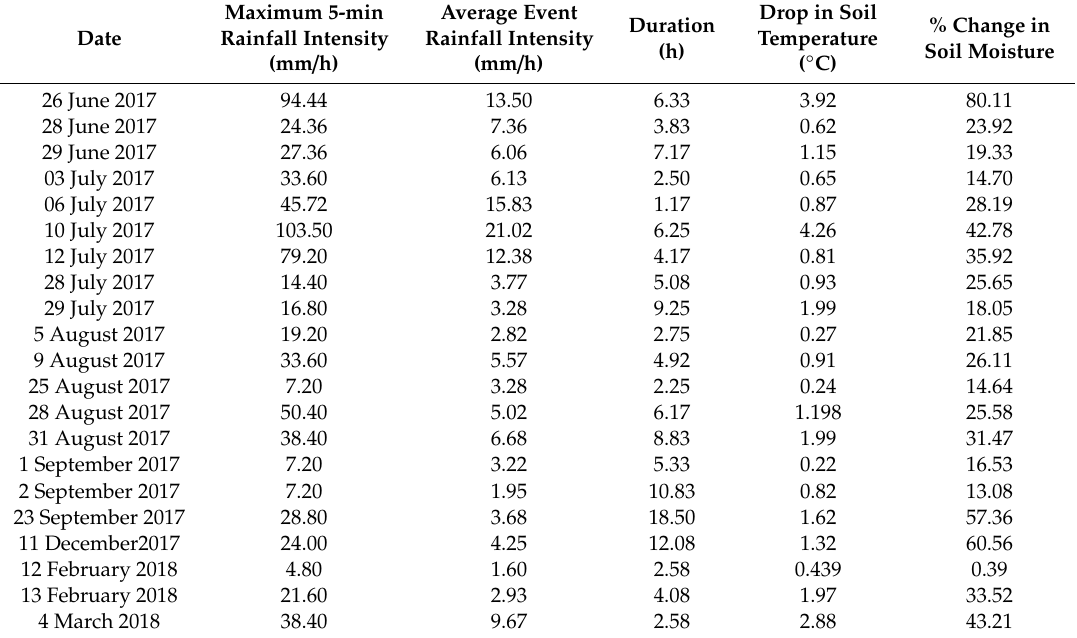
Table 2. Characteristics of selected rainfall events with corresponding changes in soil temperature and moisture in AgF